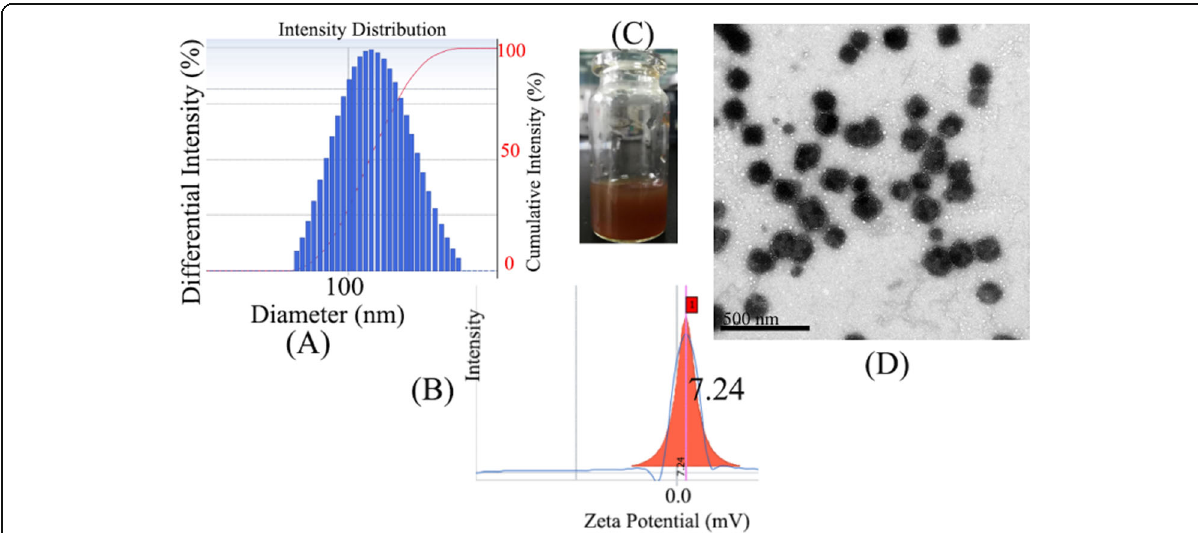
Fig. 4 a , b The size and zeta potential of Pp IX-loaded HLDM micelles. c The Pp IX-loaded HLDM micelles in water. d The TEM image of Pp IX- loaded HLDM